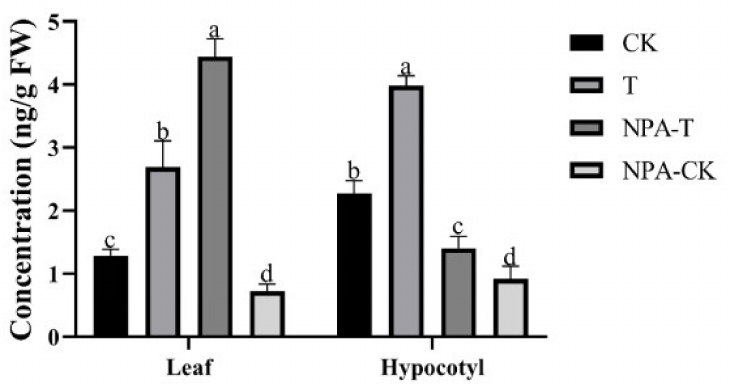
Figure 2. IAA levels in different treatments. Error bars represent ± SD. Different letters denote significant differences ( p <